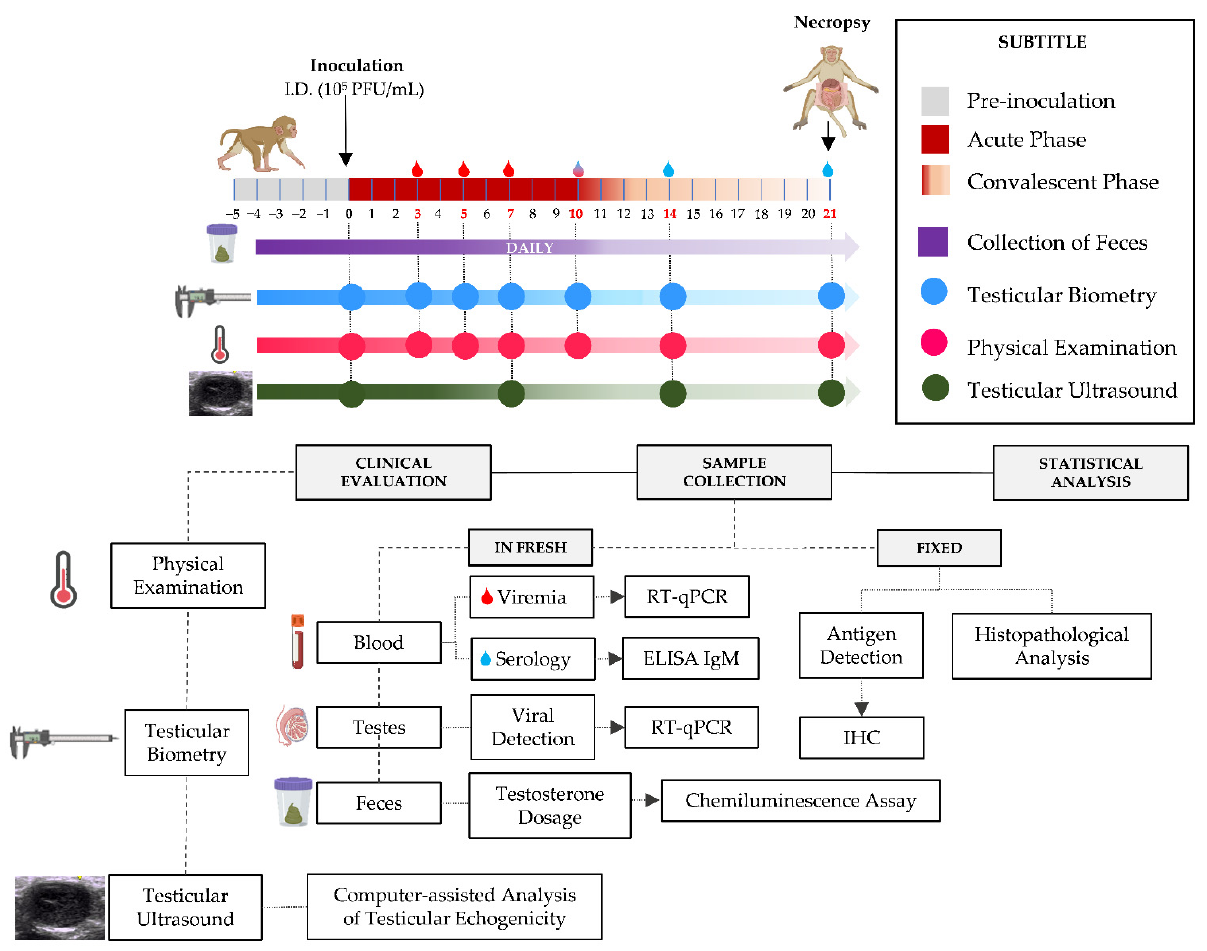
Figure 1. Experimental design of the study. The upper portion of the figure shows the timeline of sample collection and biometric data from the animals evaluated; the periods were divided into (1) Pre-inoculation, (2) Acute and (3) Convalescence phases of infection, each with its corresponding color according to the legend on the right of the figure; on the ruler we can see the days marked in red on which biological material was collected, the day of inoculation and euthanasia of the animals, as well as what was collected and evaluated, and on which days they were evaluated. In the lower portion of the figure, we have a flowchart showing to which methodology each of the samples was forwarded and the culmination of the entire study.